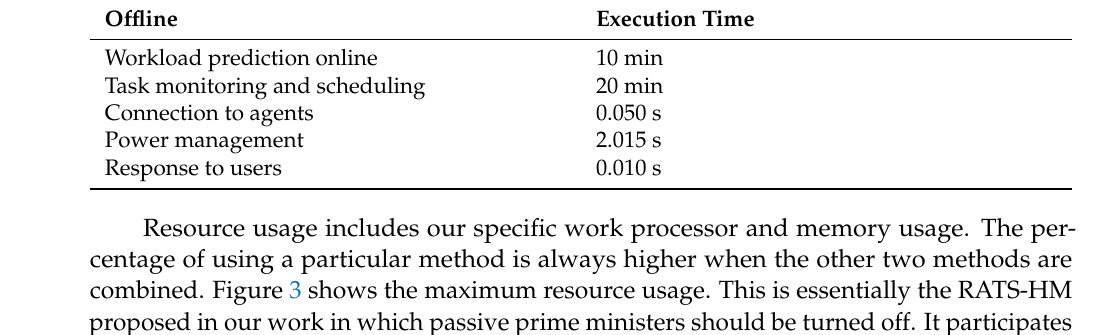
Table 4. Evaluation and analysis of response time.